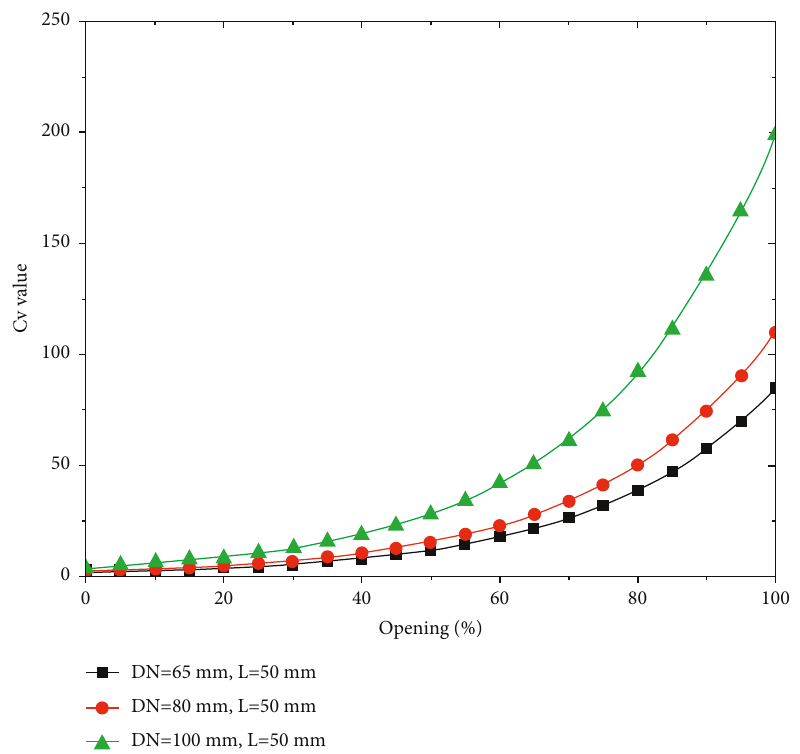
Figure 6: Variation of Cv with nominal diameter for the same stroke.